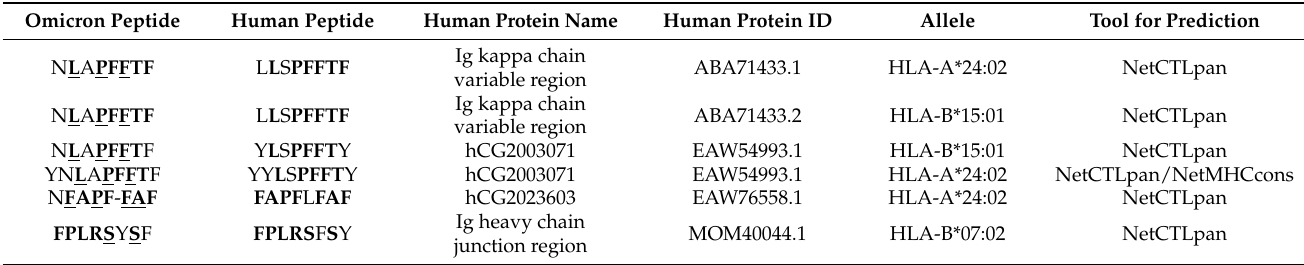
Table 1. Omicron 21K and Omicron 21L spike protein sequences with similar sequences in the human proteome and with affinities to the same HLA alleles as those of the human sequences. Omicron/human common residues are written in bold, and residues with mutations are additionally underlined. Only the highlighted results at the fifth results-line are specific to Omicron 21L [37]. Adapted with permission from Kenes.